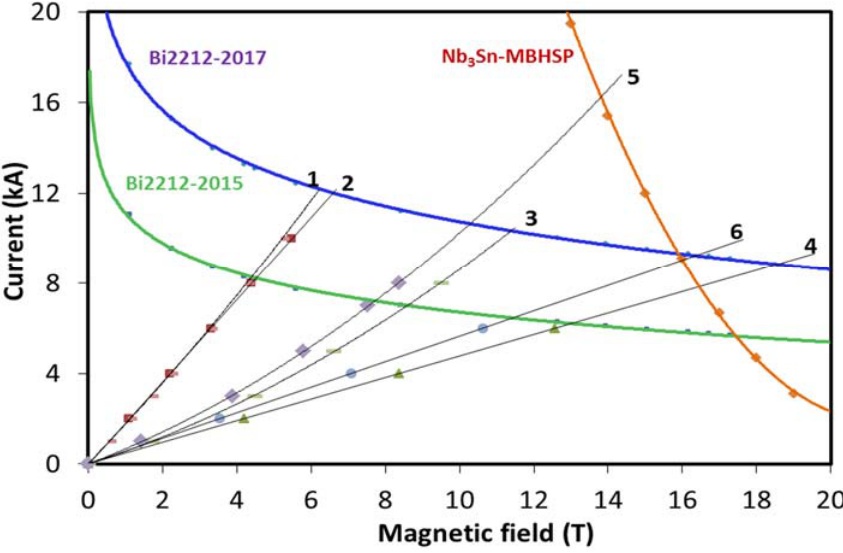
Figure 12. I c (B) curves and load lines of Bi2212 (1–4) and Nb 3 Sn (5,6) coils in various test